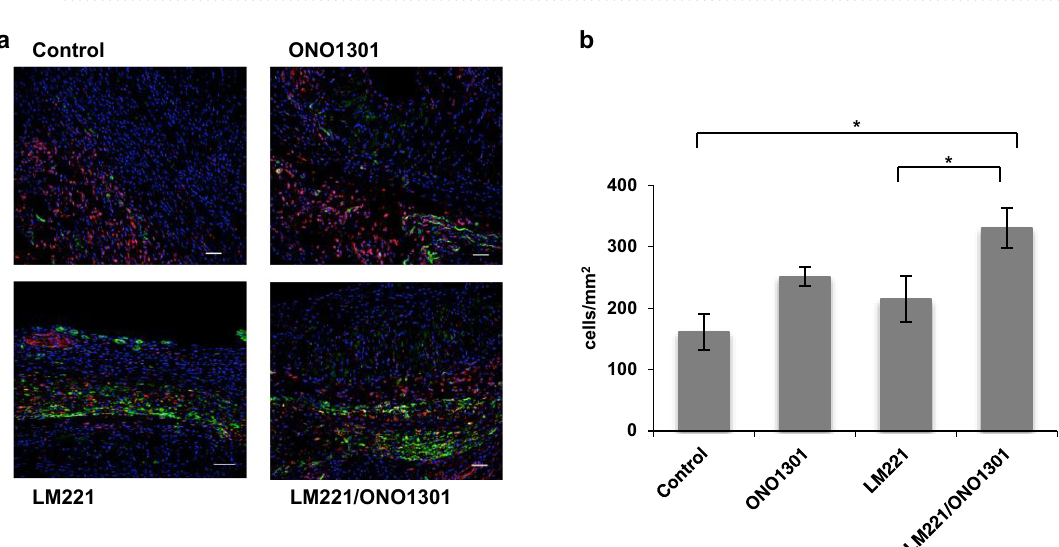
Figure 6. Combined administration of LM221 and ONO1301 increased PDGFRα and CD90 double-positive cell accumulation. PDGFRα and CD90 double-positive cells increased after the combined administration of LM221 and ONO1301, as observed by immunohistochemical analysis. Representative microscopic images show PDGFRα (red), CD90 (green), and nuclei (blue). Scale bar = 50 μm. The graph indicates the number of PDGFRα and CD90 double-positive cells at the implanted site. * p <